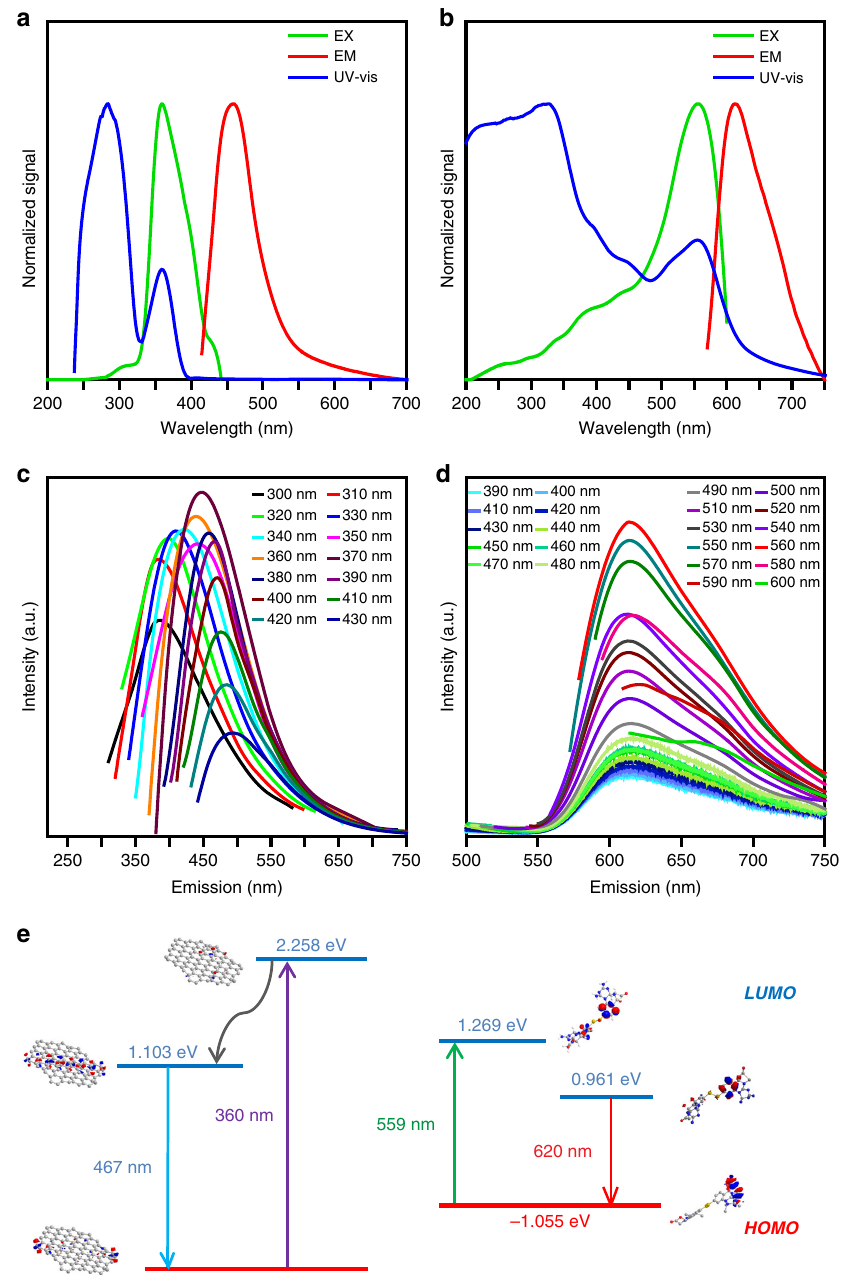
Fig. 3 Absorption and emission properties of H-CDs and concerned orbital energy level. a UV − Vis absorption (blue line), PL excitation (EX) ( λ em = 467 nm, orange line), and emission (EM) ( λ ex = 360 nm, red line) spectra of as-prepared H-CD solution. b UV − Vis absorption (green line), PL excitation (Ex) ( λ em = 620 nm, orange line), and emission (Em) ( λ ex = 559 nm, red line) spectra of the H-CD powder. c , d PL emission spectra with different